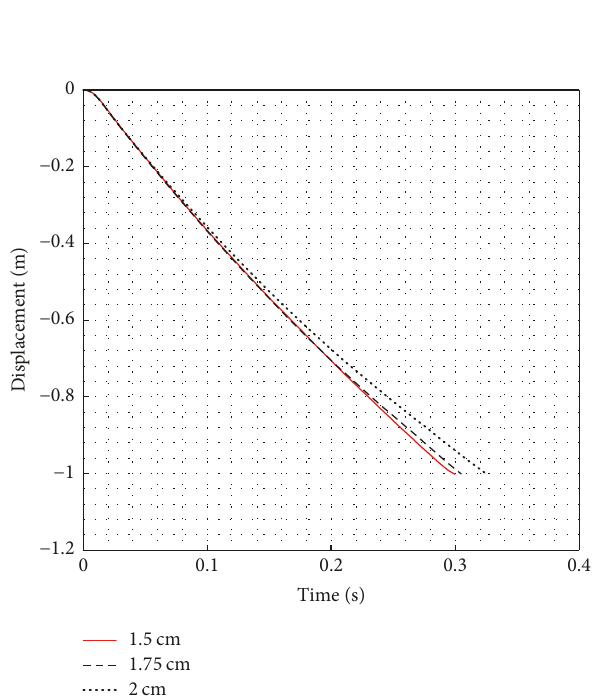
Figure 7: Comparison of the effect of the Eulerian mesh size on displacement-time graph of spherical pounder.